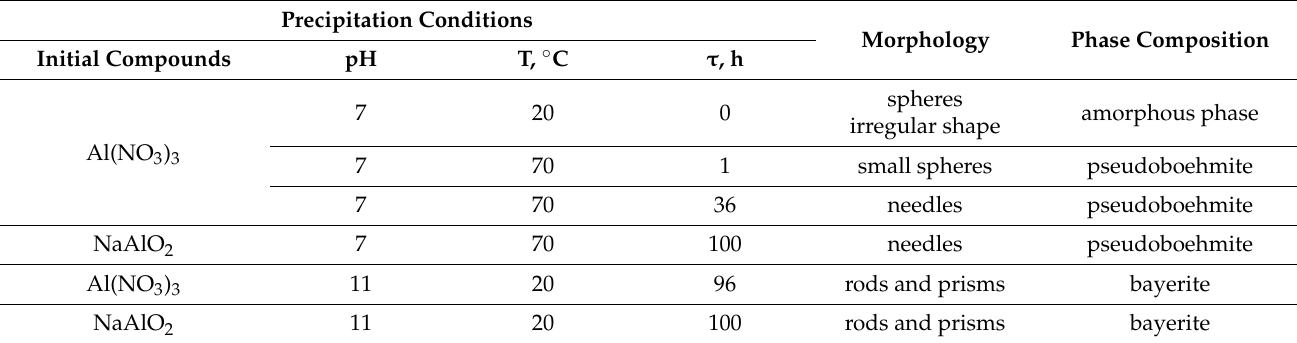
Table 1. Influence of precipitation conditions (pH, T, and τ -aging duration) on the phase composition of the products and their morphology [20]. Copyright Elsevier,